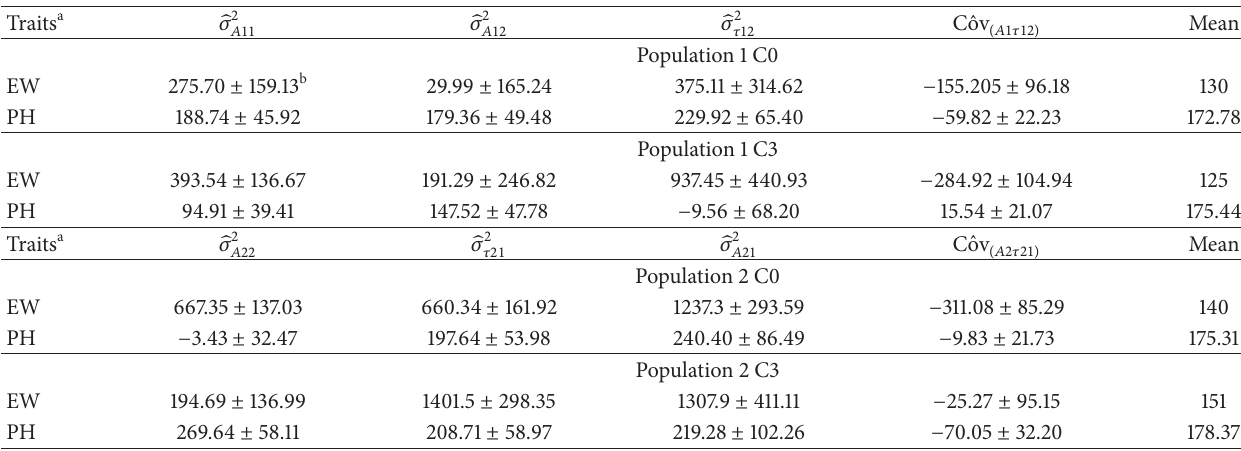
Table 3: Estimates for intrapopulation ( ̂𝜎 2 𝐴11 and ̂𝜎 2 𝐴22 ) and interpopulation ( ̂𝜎 2 𝐴12 and ̂𝜎 2 𝐴21 ) additive genetic variances, variances of deviations of the intra- by interpopulation additive effects ( 𝜎 2 𝜏 ), and covariances of additive effects with their deviations (Cˆov 𝐴𝜏 ) in evaluations of intra- and interpopulation half-sib progenies from cycles 0 and 3 (C0 and C3).